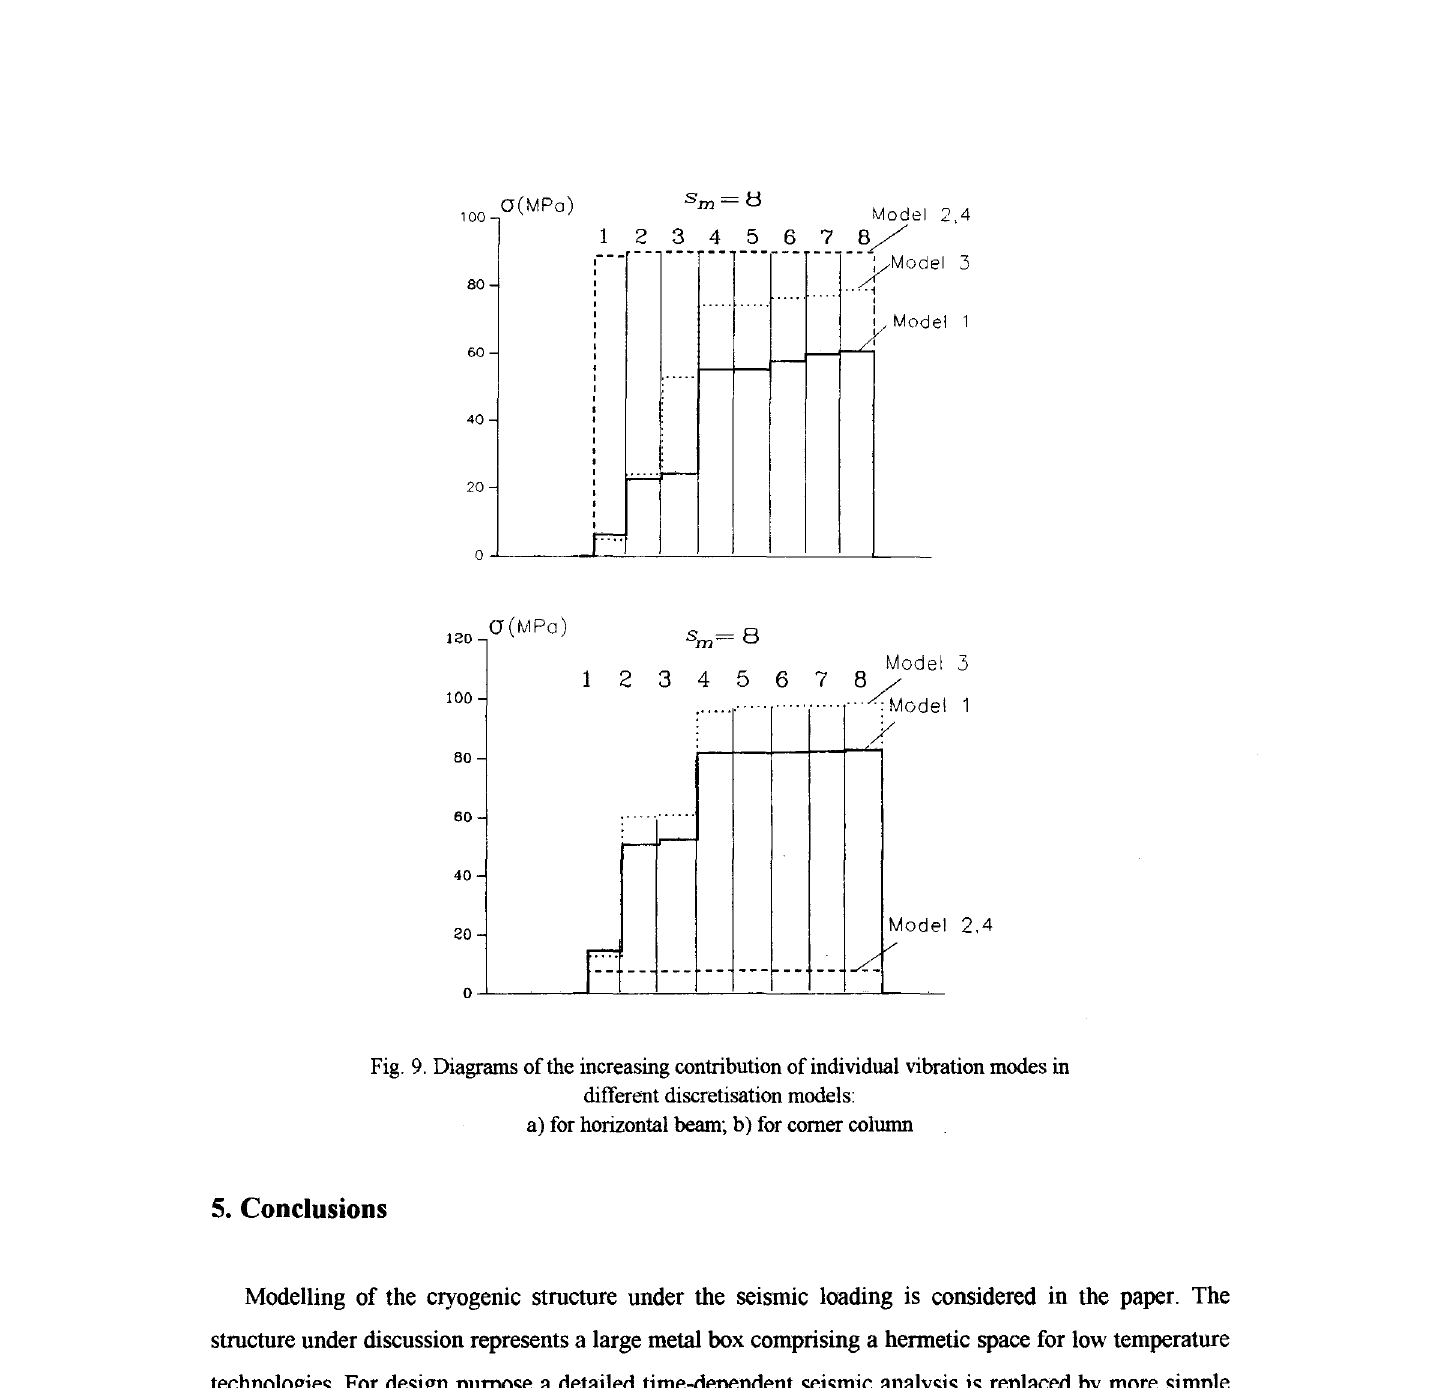
Fig. 9. Diagrams of the increasing contribution of individual vibration modes in different discretisation models: a) for horizontal beam; b) for comer